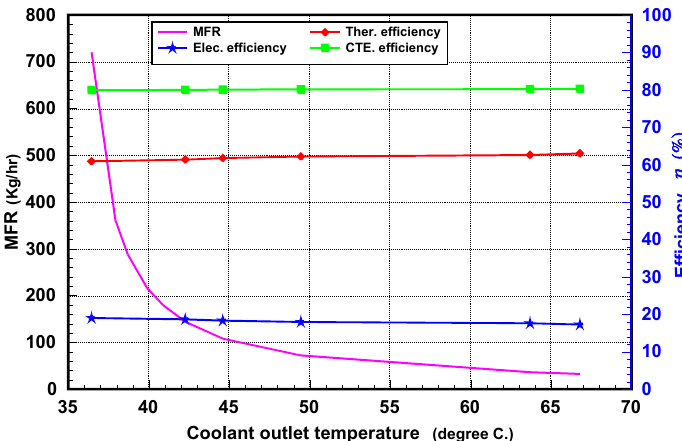
Figure 19. The variation of the CPVT collector mass flow rate, Electrical, Thermal, and CTE efficiencies with the coolant outlet temperature (constant T inl = 35 °C).